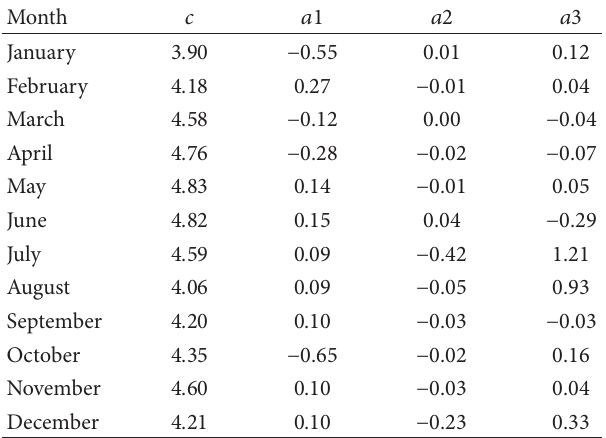
Table 2: Multiple linear regression coefficients for the 5 main PCs.